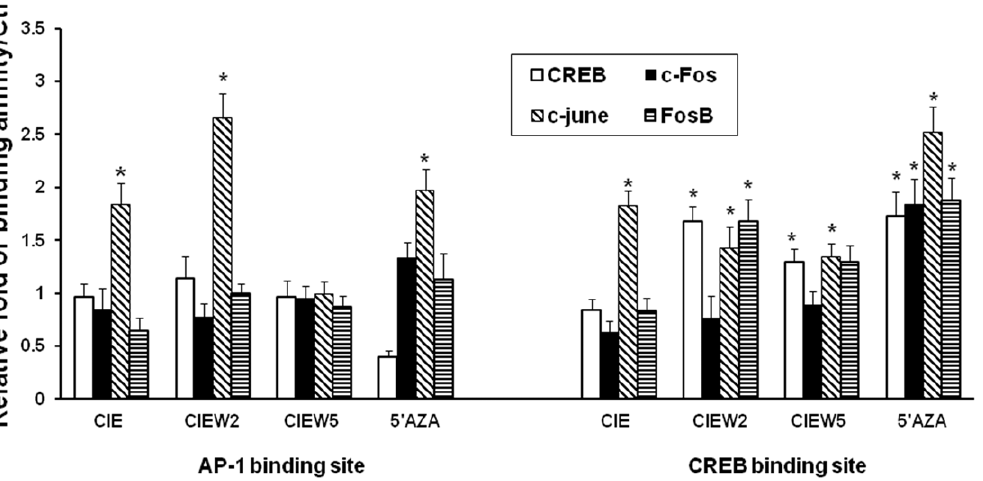
Figure 8. 5 9 AZA and CIE cause increased the occupancy of transcription factors with chromatin. The cultured neuronal cells were treated by 5 9 AZA (4 days) or CIE. The chromatin fragments were prepared by cross-linking using 1% formaldehyde and precipitating with antibodies, CREB, c- Fos, c-Jun and FosB. The qChIP PCR was performed by using the primers amplifying the regions containing CRE and AP-1 sites, respectively. *, p , 0.05 compared to the control.